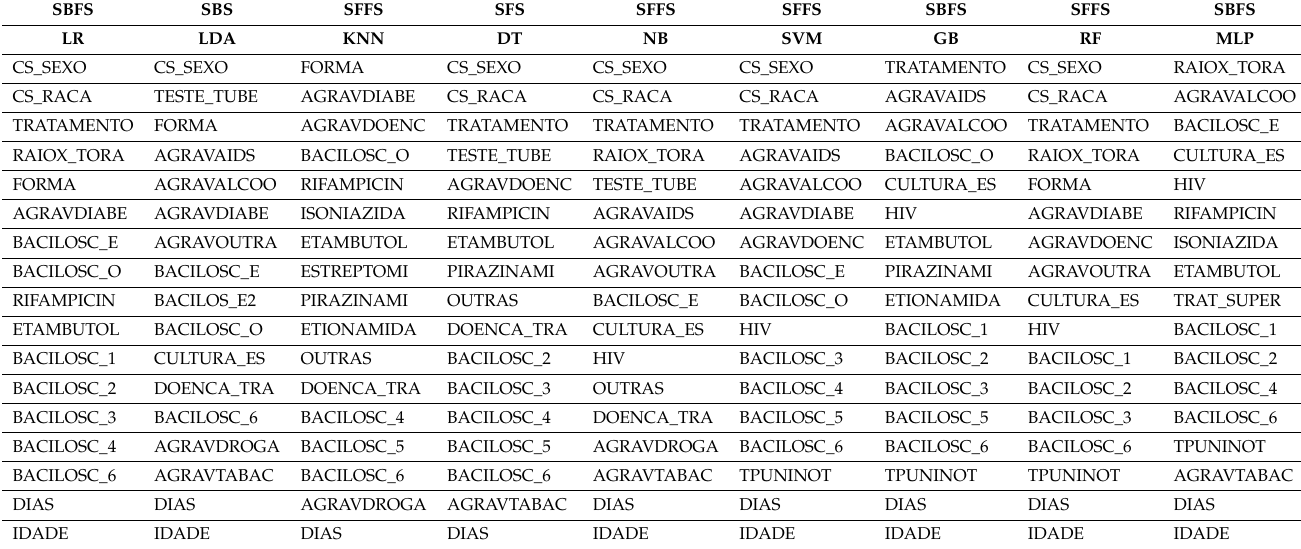
Table 2. Features selected through the best F1-score average of feature selection